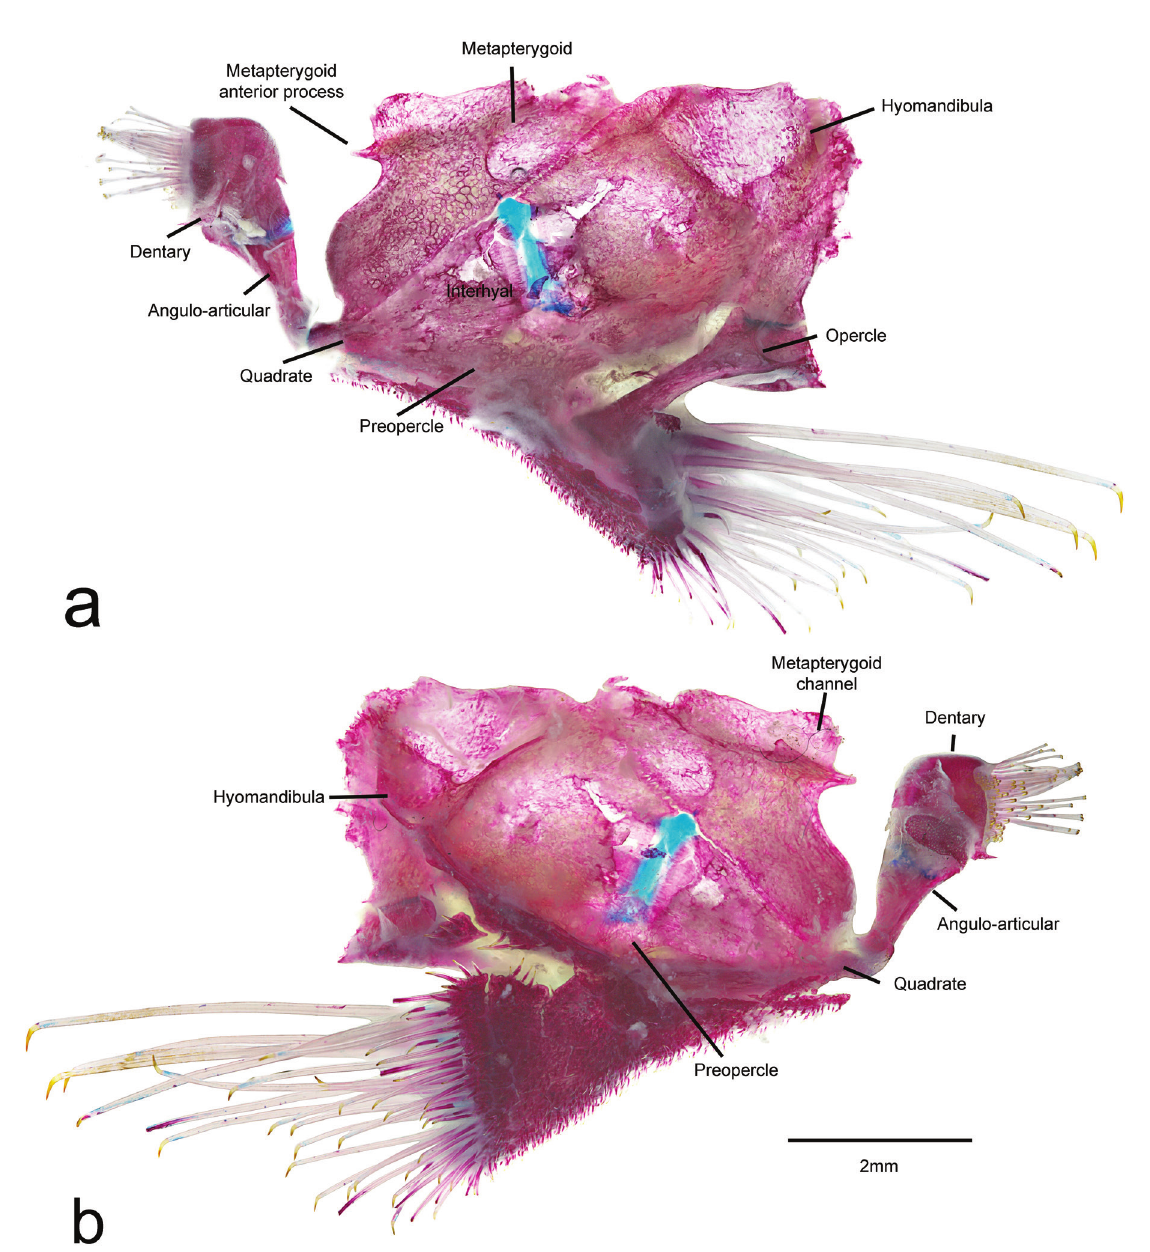
Fig. 12. Suspensorium of Spectracanthicus immaculatus , (a) external view and (b) internal view, paratype, MZUSP 92617, 58.9 mm SL. Scale bars = 2 mm. Image by E.